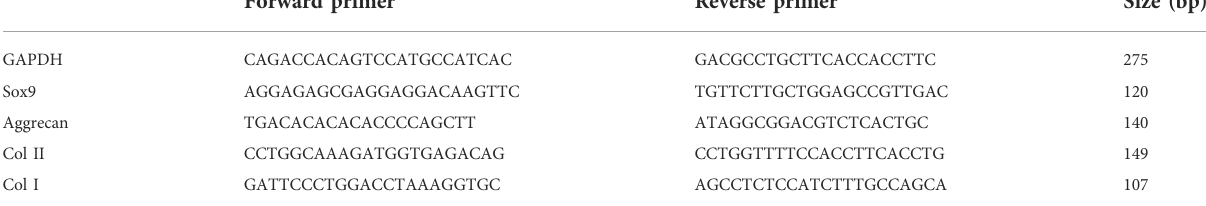
TABLE 1 Speci fi c primers for